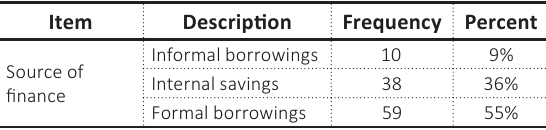
Table 1. Loan repayment